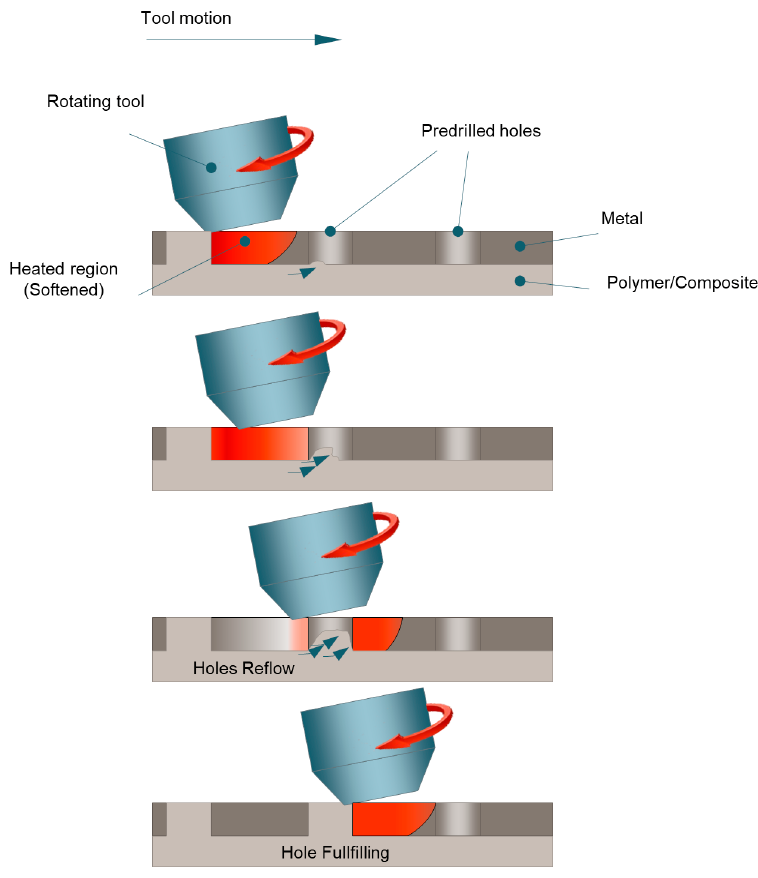
Figure 10. Schematic of the hole fulfilling development during friction self-riveting.